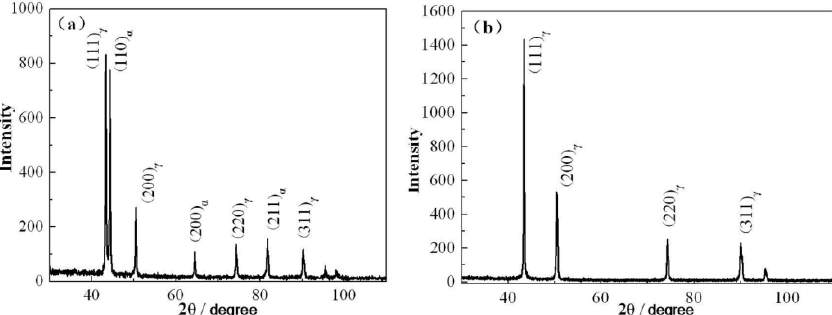
Figure 2. Thermodynamic calculation phase diagrams of steel ( a ) without and ( b ) with added nitrogen.